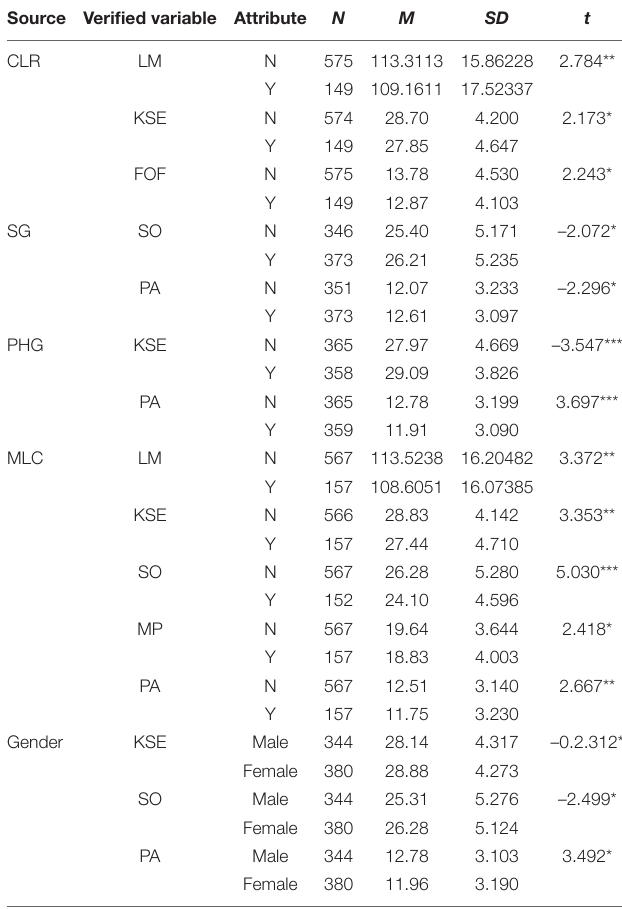
TABLE 5 | Comparison of learning motivation by temperament and gender ( t